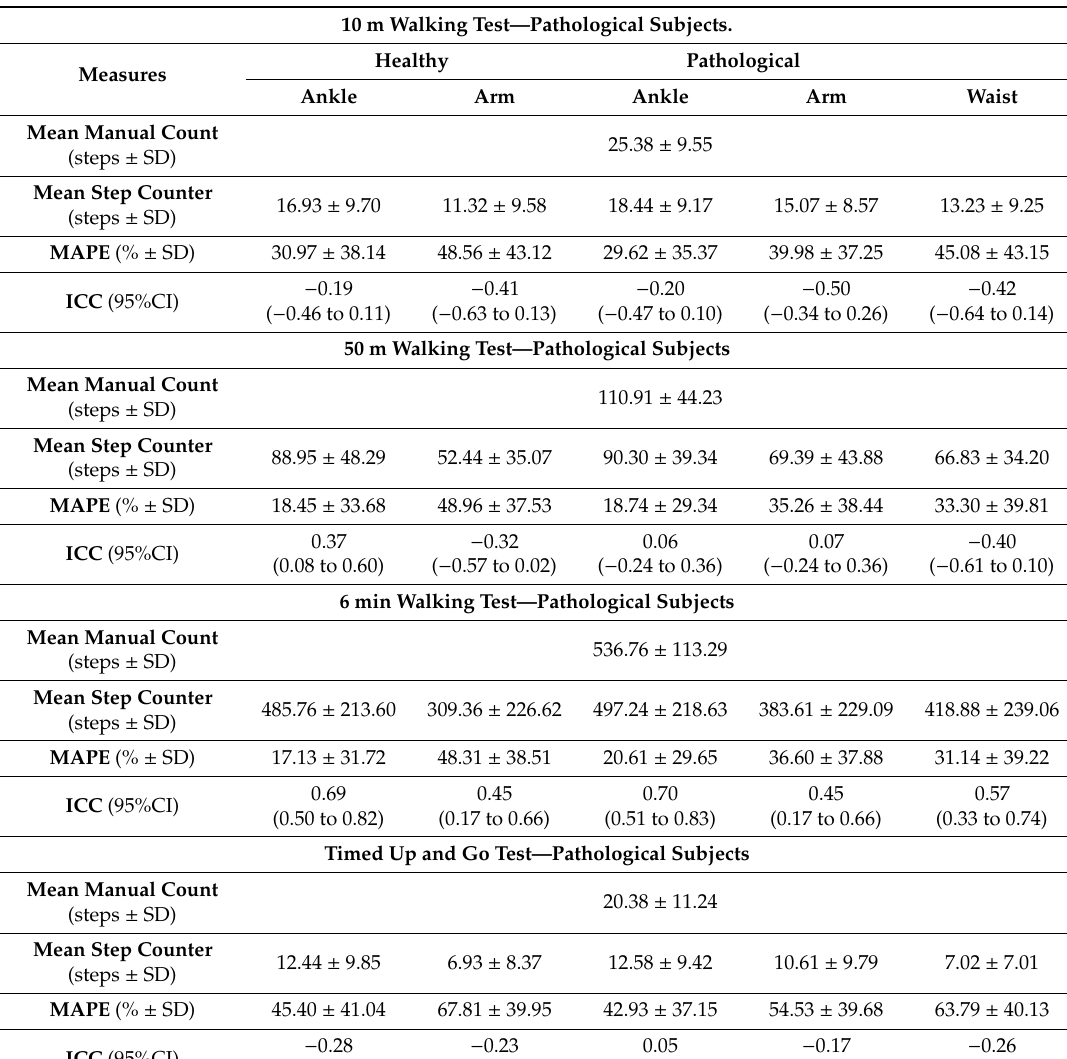
Table 3. Mean absolute percentage error and intraclass correlation coe ffi cient for manually counted steps and steps counted using step counters in di ff erent positions in pathological subjects ( n = 43). 10 m Walking Test—Pathological